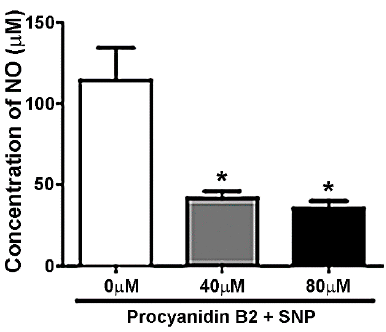
Figure 7. PB2 Reduces Nitric Oxide Concentration Produced by SNP in a Cell-Free System. Quantitative analysis of nitric oxide generation by SNP in the presence of PB2. Data are expressed as the mean ± SEM, n = 3. * indicates p < 0.05 in comparison to samples containing SNP alone. See Materials and Methods section for a detailed explanation of the experimental protocol.